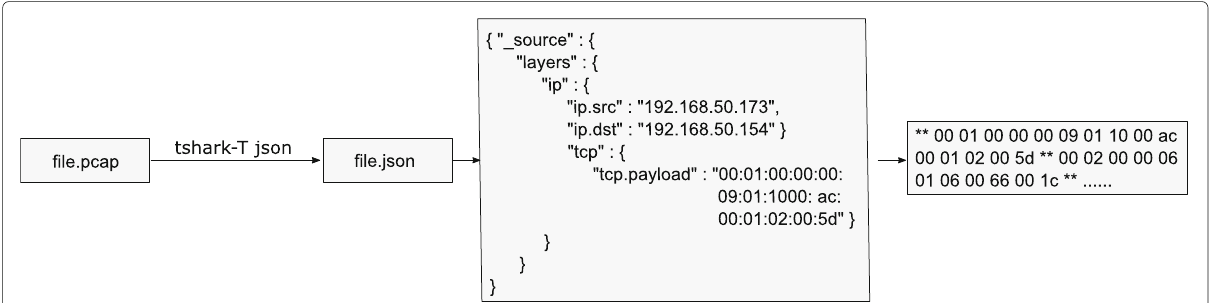
Fig. 2 The filtering process. Conversion of the PCAP file into a JSON file, and then extraction of the information of tcp.payload according to the role of the system